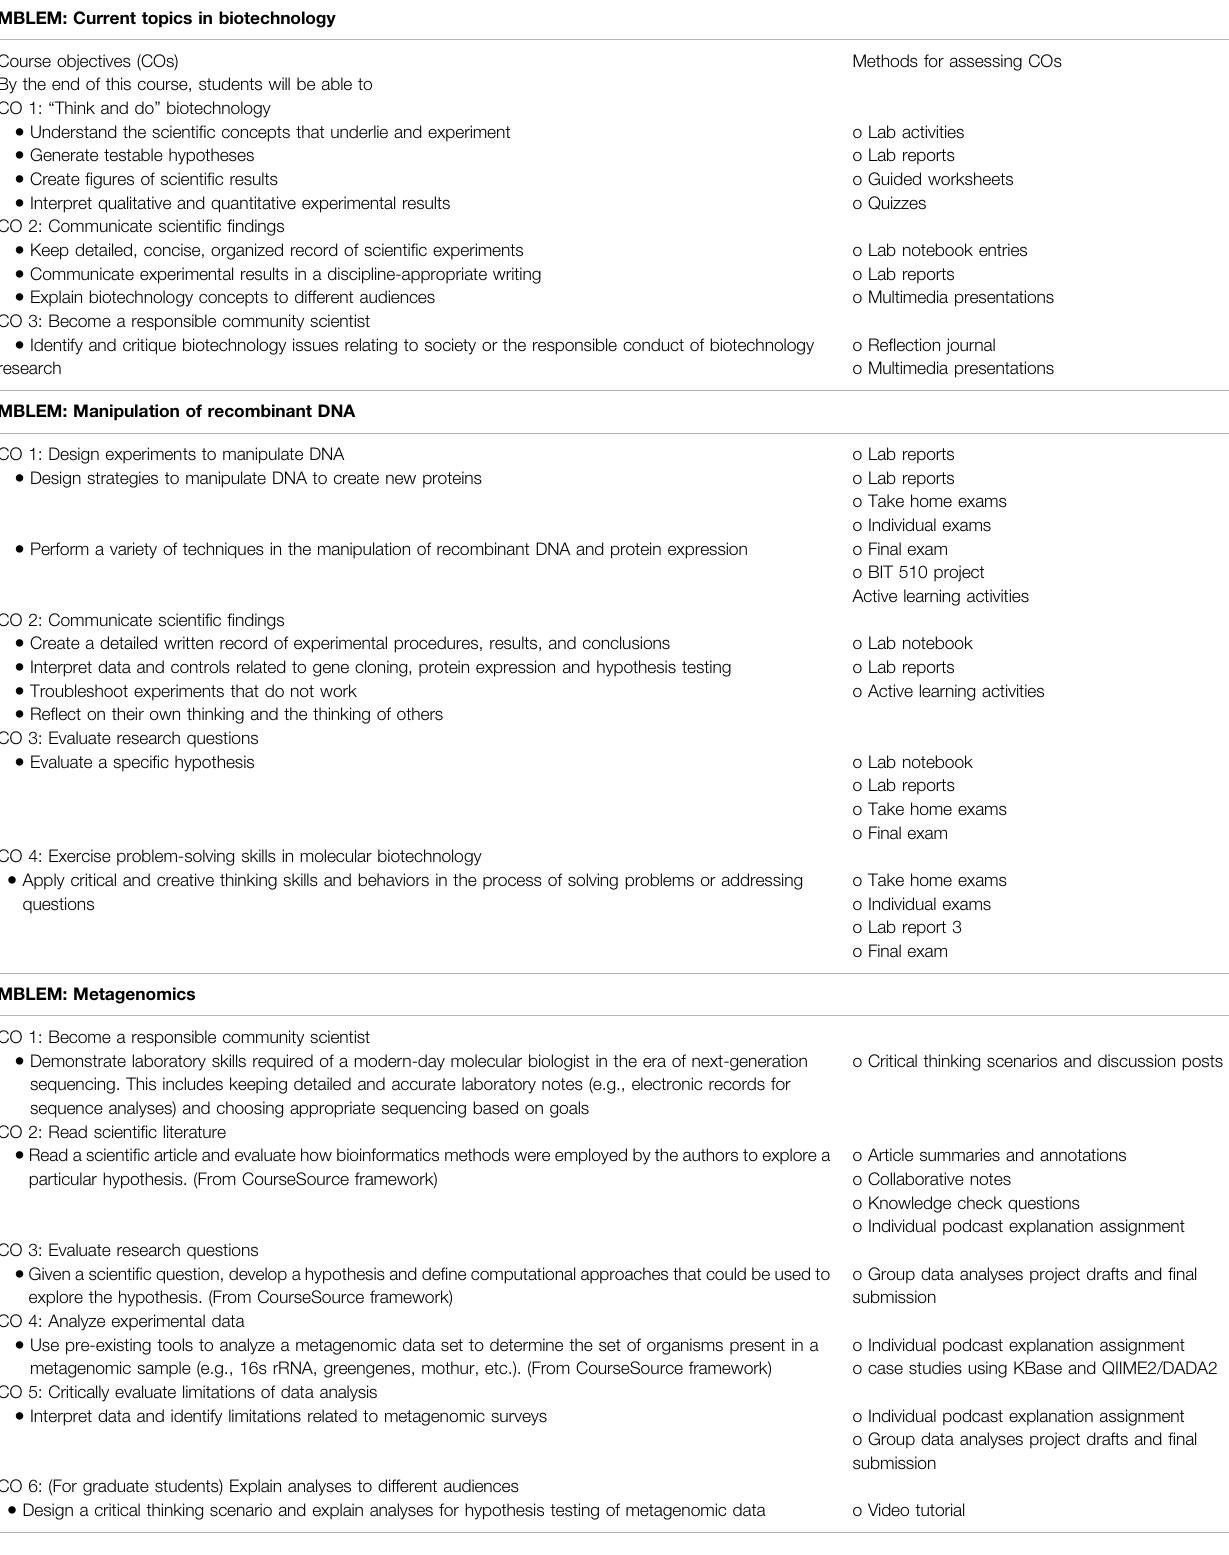
TABLE 1 | MBLEM course objectives and assessment